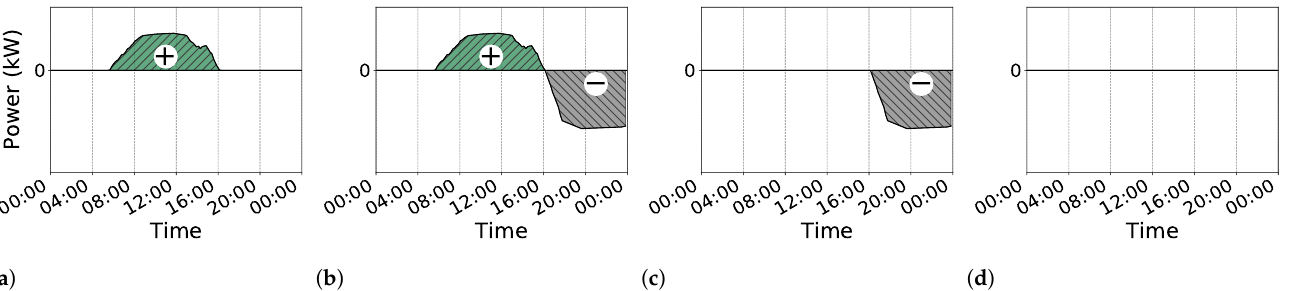
Figure 6. Distribution possibilities of renewable energy surplus and deficit after V2G application. ( a ) RE surplus. ( b ) RE surplus and deficit. ( c ) RE deficit. ( d ) Surplus deficit